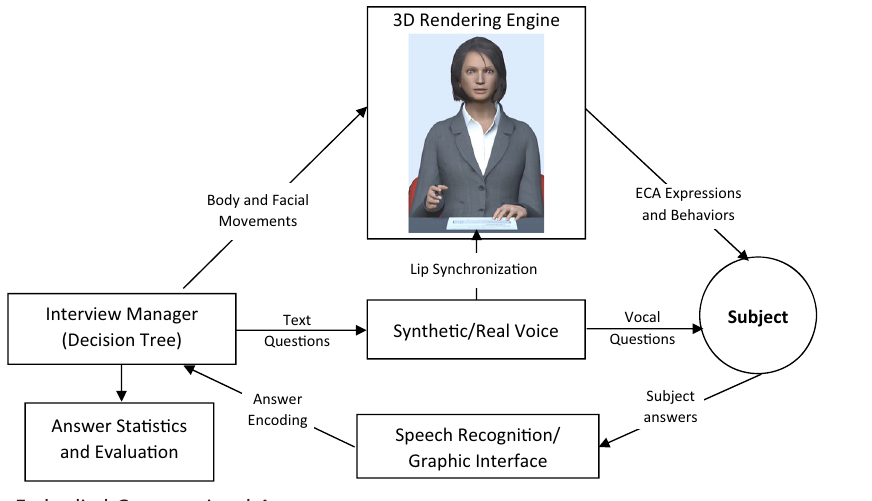
Fig. 4 Architecture of the Embodied Conversational Table 2. English and French versions of the ECA Trust Questionnaire (ETQ) and the Acceptability E-scale (AES). No. Factor